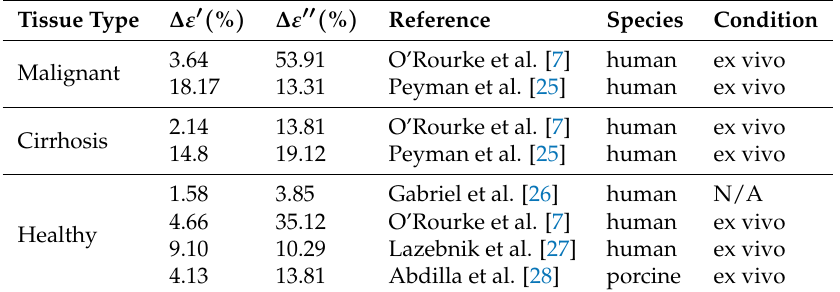
Table 5. Comparison of measured mean in vivo dielectric properties of malignant, cirrhosis, and healthy tissues with literature data.